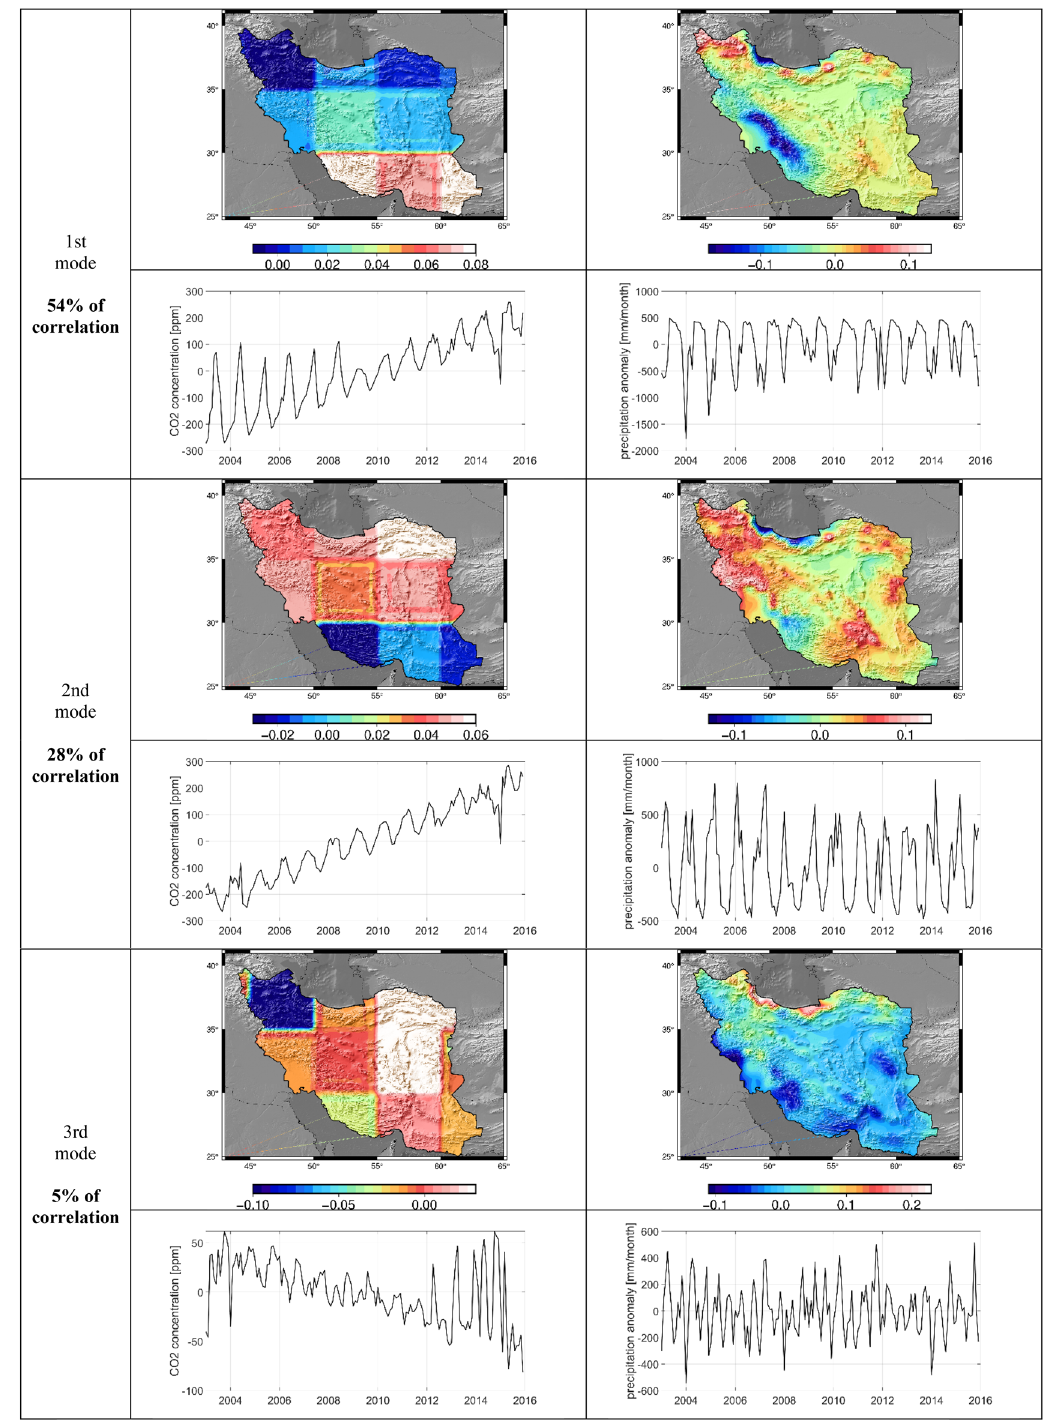
Figure 9. Results of CCA analysis between CO 2 and Precipitation for the first three modes carrying 87% of the correlation. For each mode, time series and maps of canonical modes are shown for both CO 2 concentration (left) and precipitation